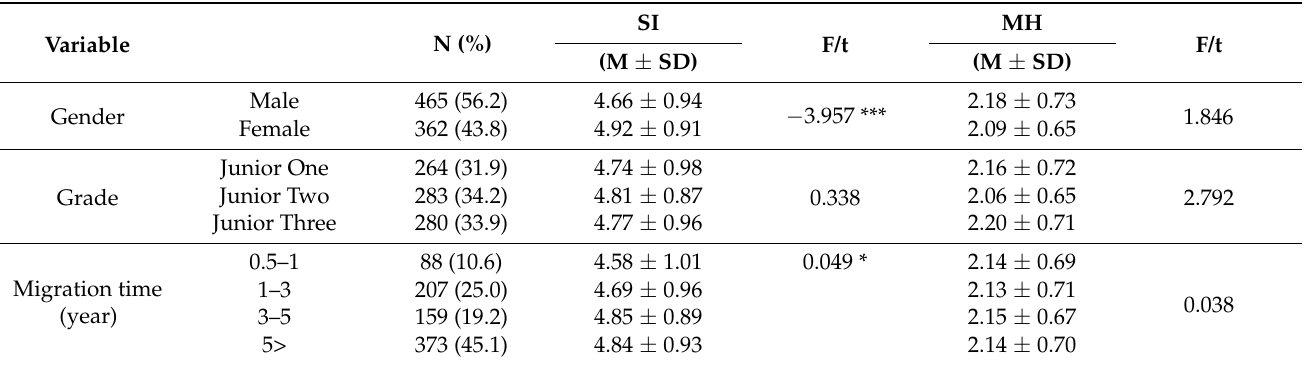
Table 1. Demographic characteristics of the study population and their relationship to social identity and mental health (n =